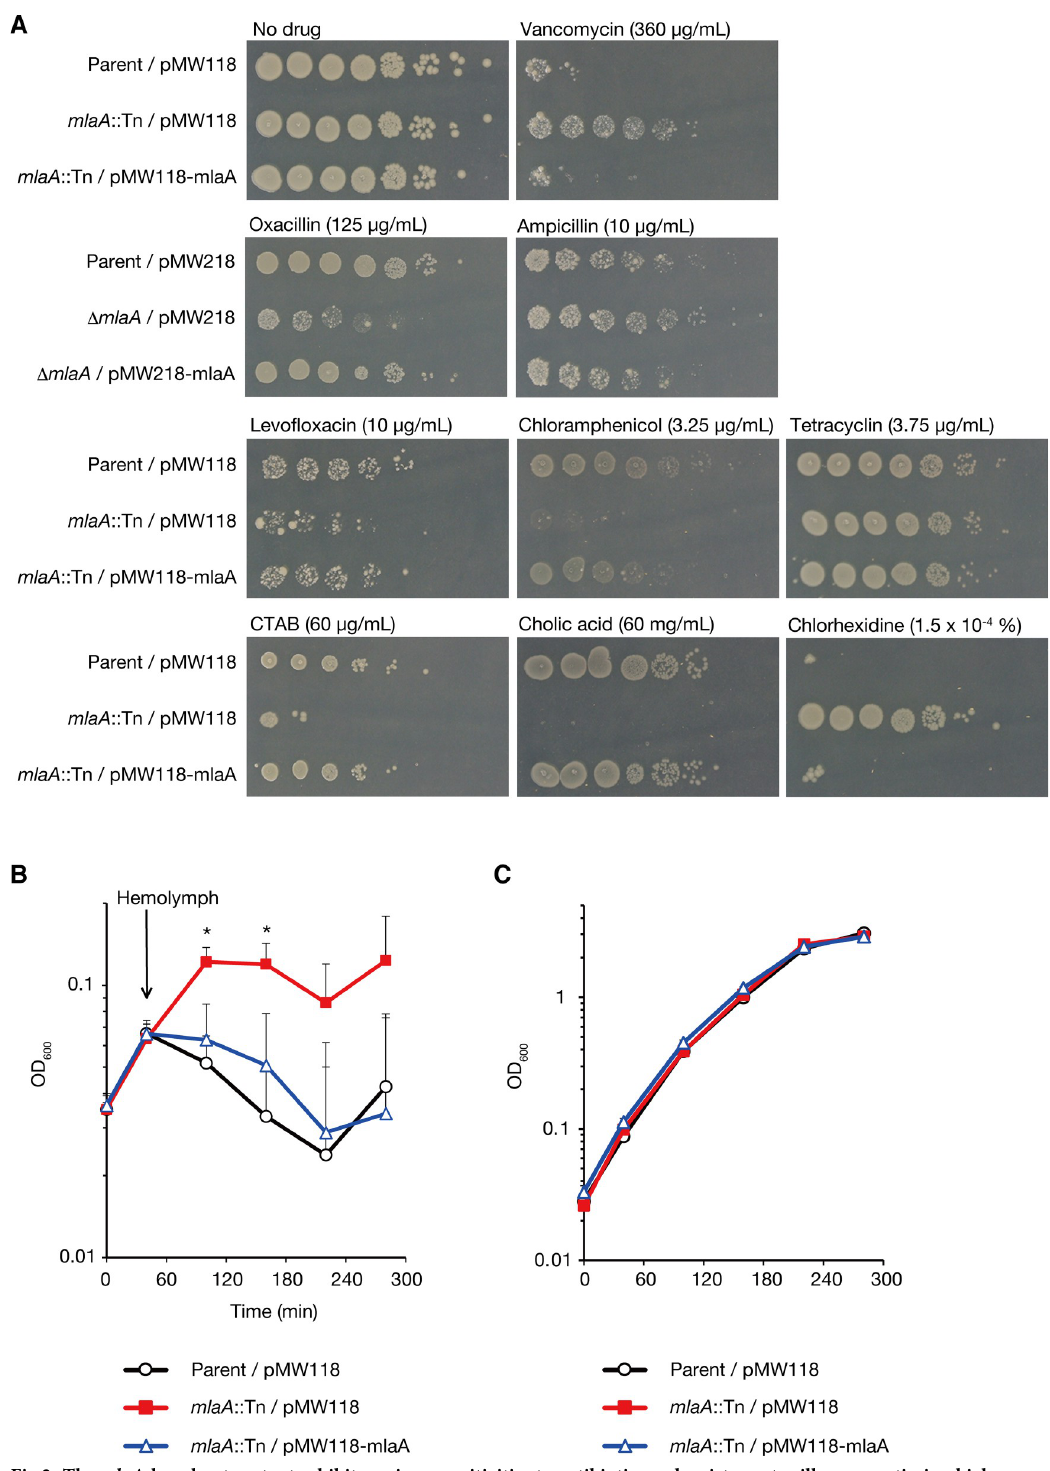
Fig 2. The mlaA- knockout mutant exhibits various sensitivities to antibiotics and resistance to silkworm antimicrobial substances. (A) E . coli overnight culture of the Parent/pMW118, mlaA ::Tn/pMW118, or mlaA ::Tn/pMW118-mlaA strain was 10-fold serially diluted; spotted onto LB agar plates supplemented with or without vancomycin, levofloxacin, chloramphenicol, tetracycline, CTAB, cholic acid, or chlorhexidine; and incubated at 37˚C. To examine the sensitivity to oxacillin and ampicillin, the mlaA deletion mutant (markerless deletion mutant of mlaA ) transformed with pMW218 ( Δ mlaA /pMW218) and the mlaA deletion